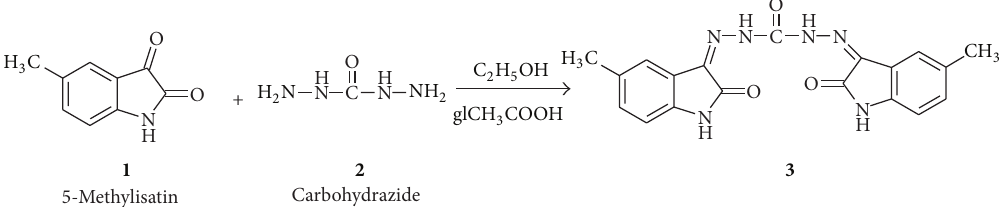
Scheme 1: Synthetic route for the bis-isatin derivative 3